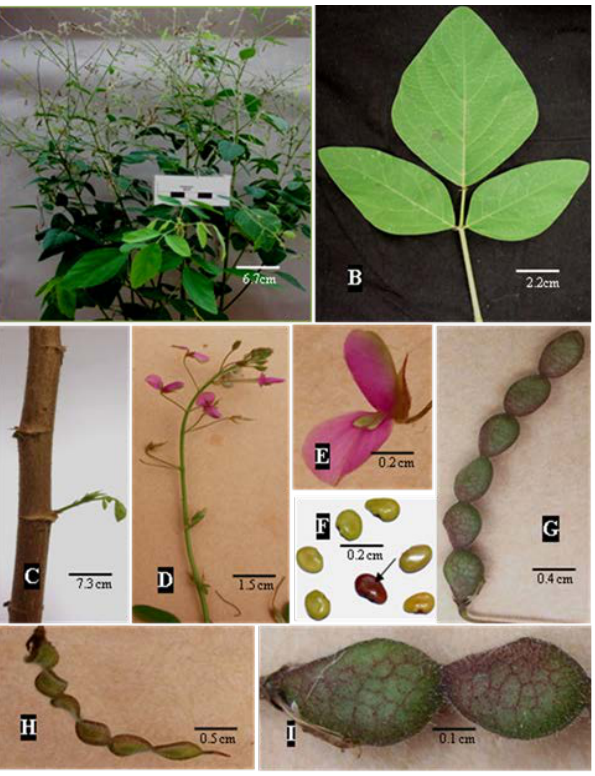
Fig. 2. Morphology of Desmodium scorpiurus (Sw.) Desv Fruits (showing hairs)